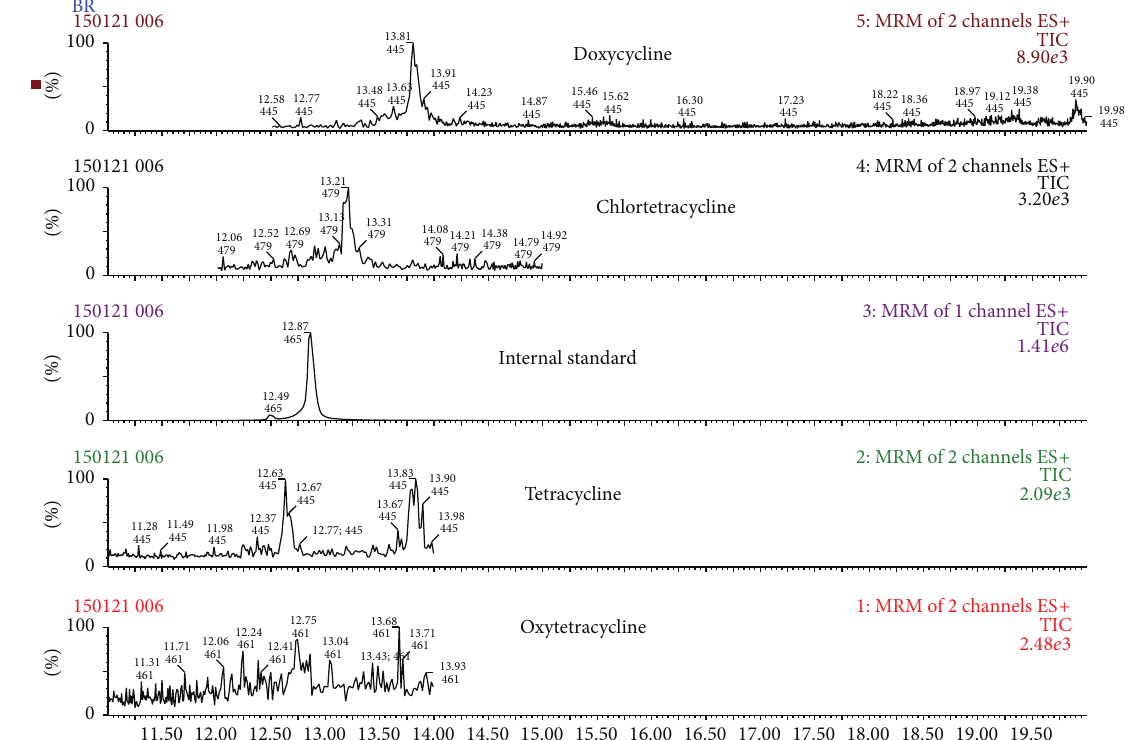
Figure 1: SRM chromatograms of tetracyclines in a blank sample.